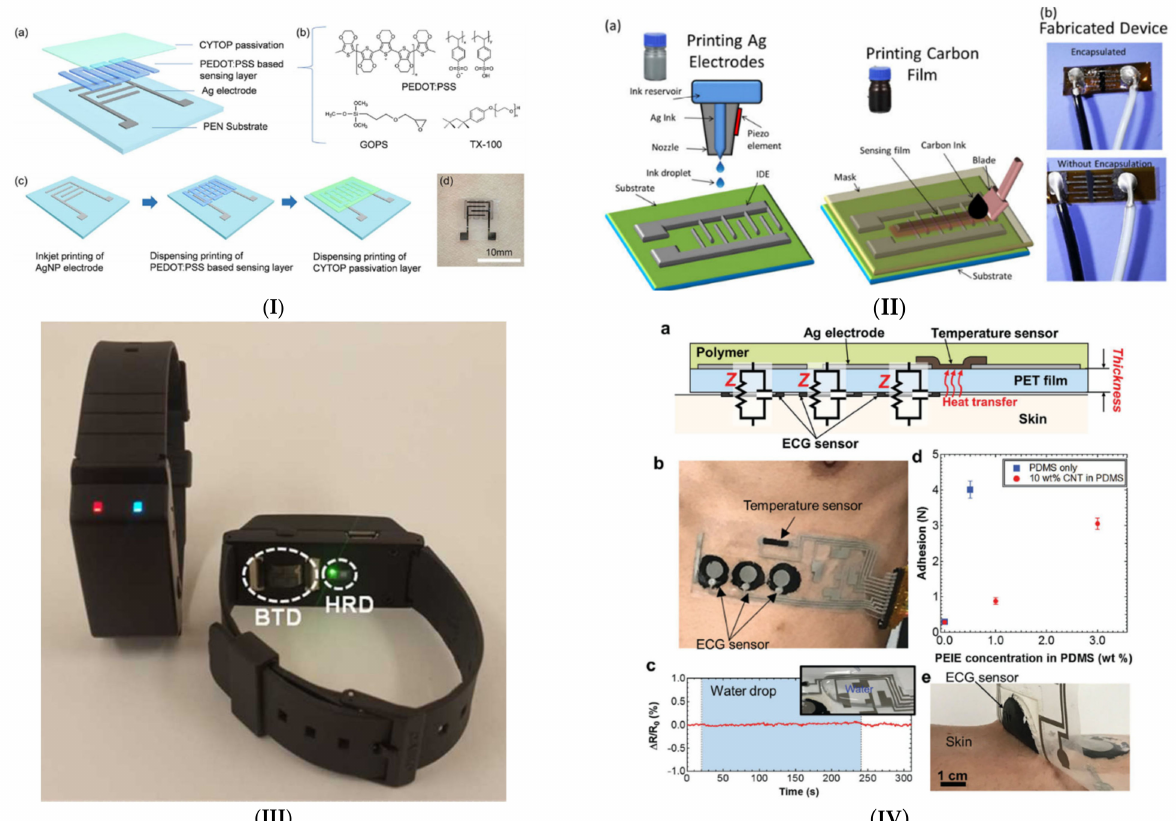
Figure 4. Selected printed wearable temperature sensors. ( I ) Inkjet-printed PEDOT:PSS sensor by Wang et al. [223] used under the terms of Creative Commons Attribution 4.0 International license, ( II ) Wrist carbon-based temperature sensor by Ali et al. [224] used under the terms of Creative Commons Attribution 4.0 International license, ( III ) Resistive PEDOT:PSS sensor fixed on a watch-style band by Han et al. [227] used under the terms of Creative Commons Attribution Non- Commercial License, and ( IV ) Resistive chest CNT sensor by Yamamoto et al. Reused with permission [226,228] Copyright (2017), John Wiley and